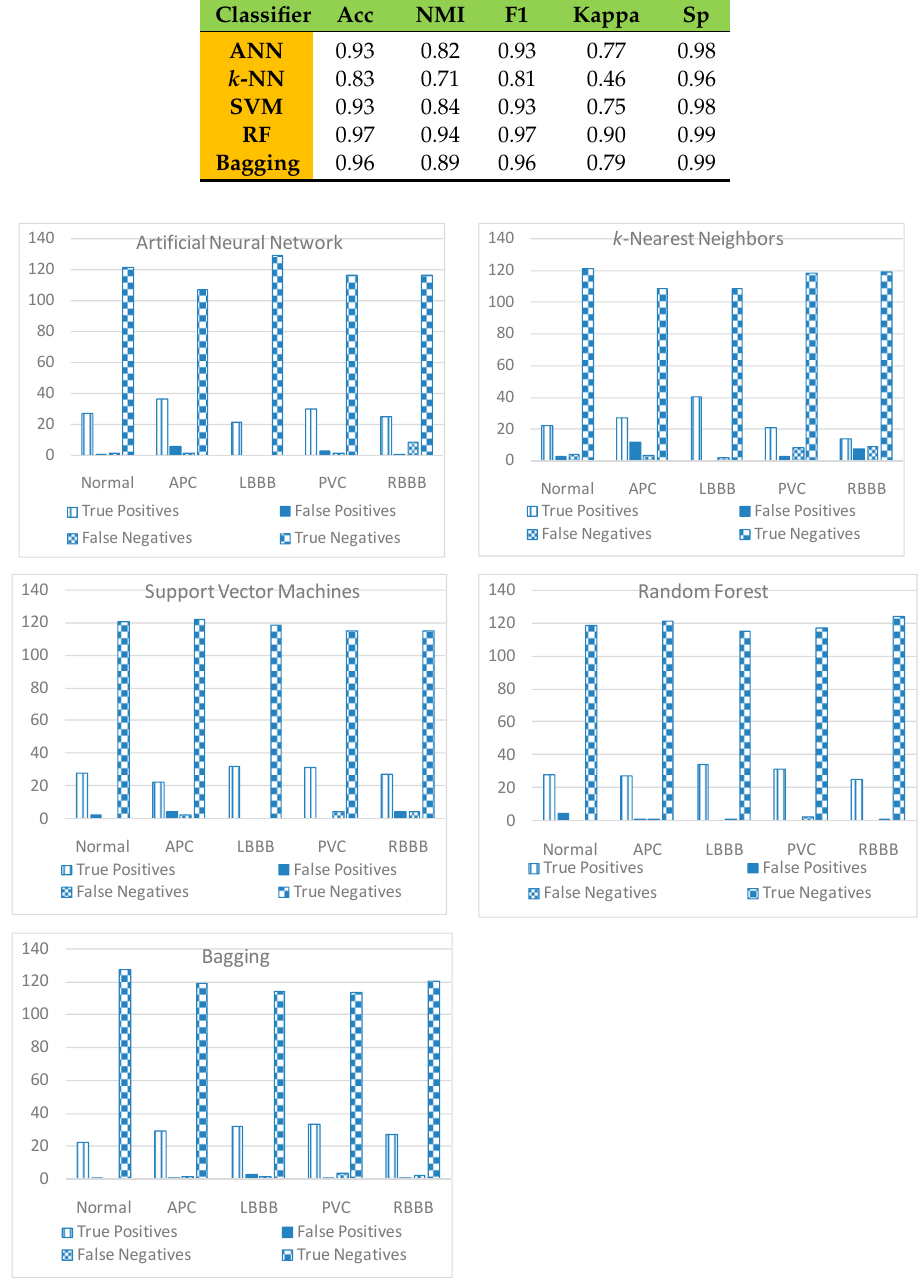
Figure 8. True positive (TP), false positive (FP), false negative (FN), and true negative (TN) for different ECG classes.